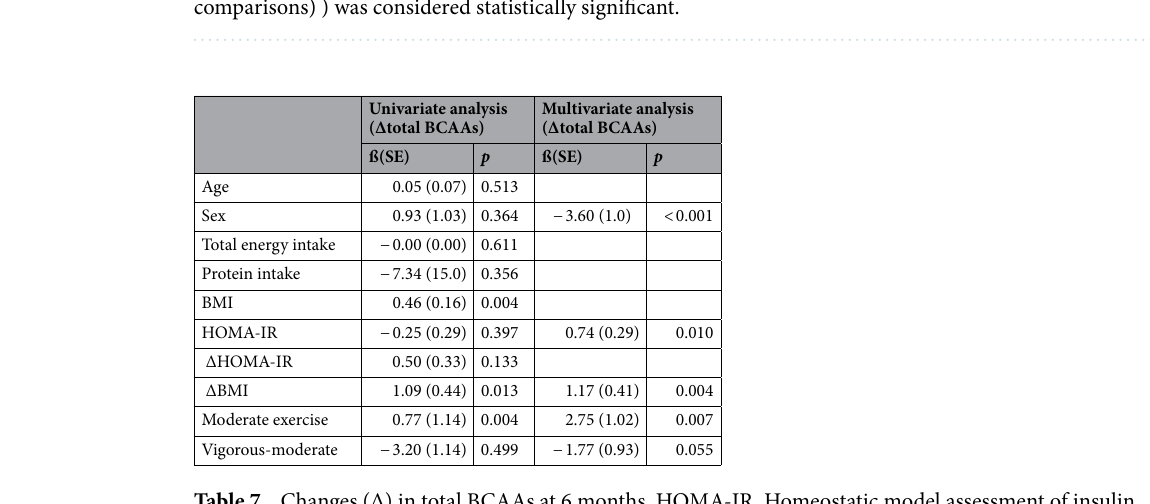
Table 7. Changes (Δ) in total BCAAs at 6 months. HOMA-IR, Homeostatic model assessment of insulin resistance; BMI, body mass index. ΔHOMA-IR and ΔBMI: changes in HOMA-IR and BMI from baseline to 6